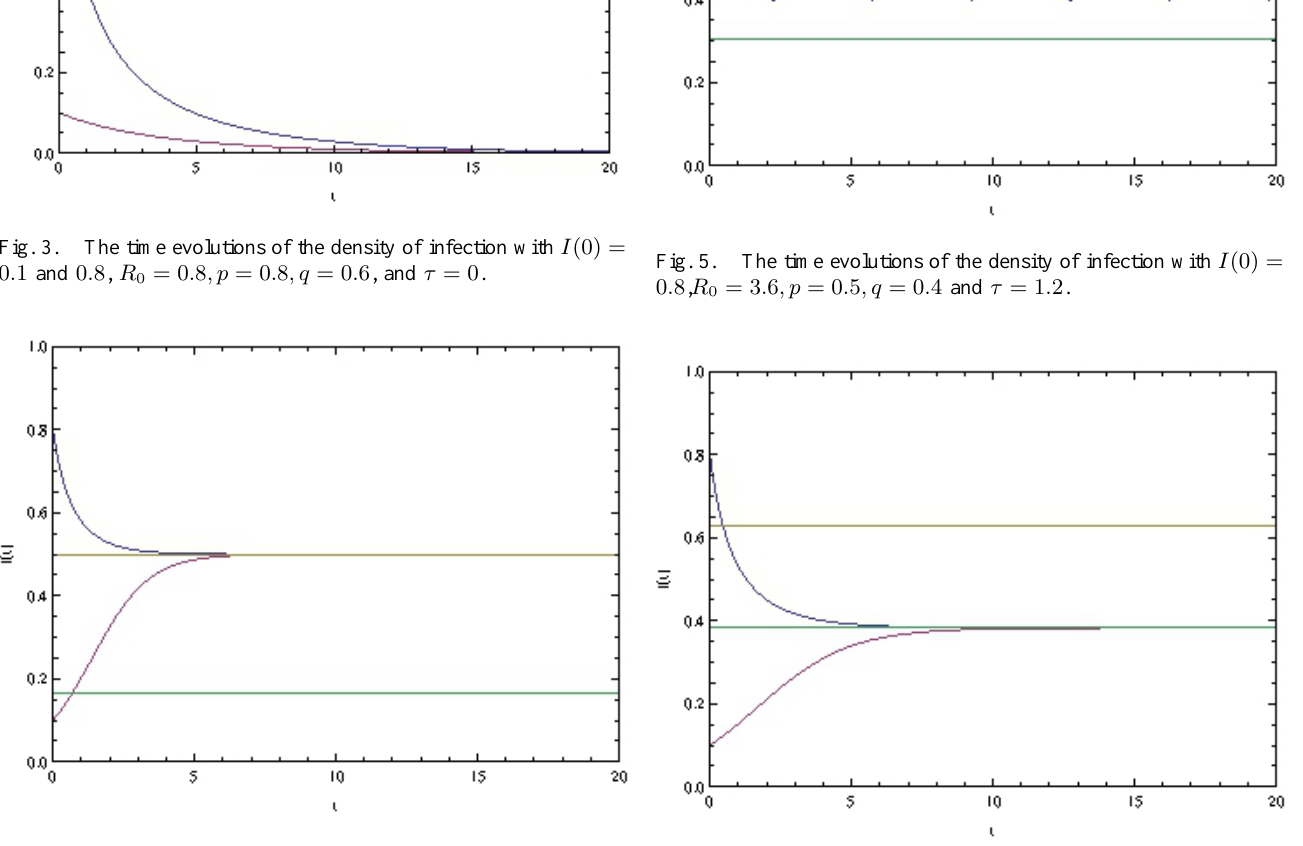
The time evolutions of the density of infection with I (0) = 0 . 1 and 0 . 8 , R 0 = 2 , p = 0 . 8 , q = 0 . 6 and τ = 0 .